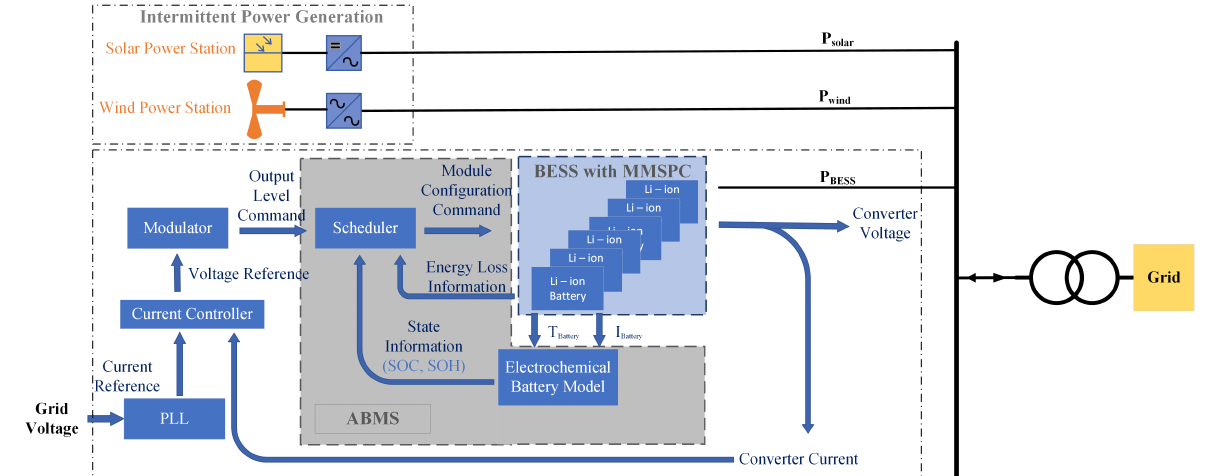
Figure 3. The schematic diagram of the proposed ABMS, BESS grid connectivity, and